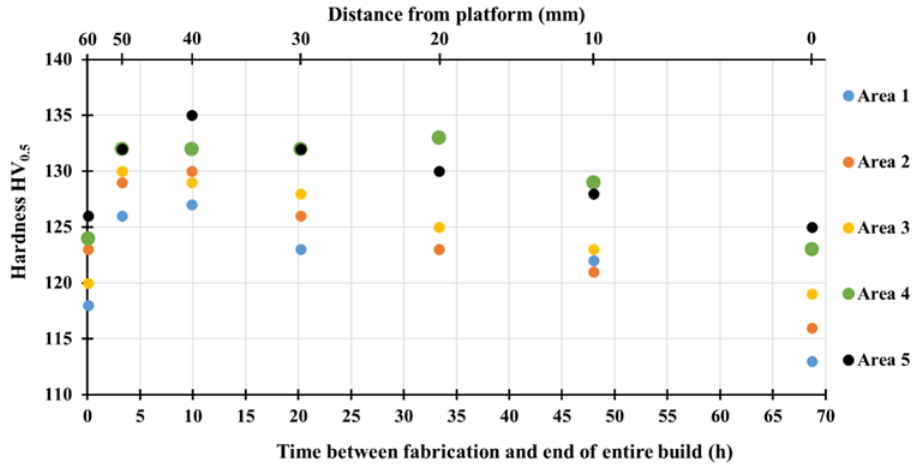
Figure 8. Evolution of hardness HV 0.5 as a function of the time between the fabrication of the cross-section considered and the end of the building process for each building area considered.